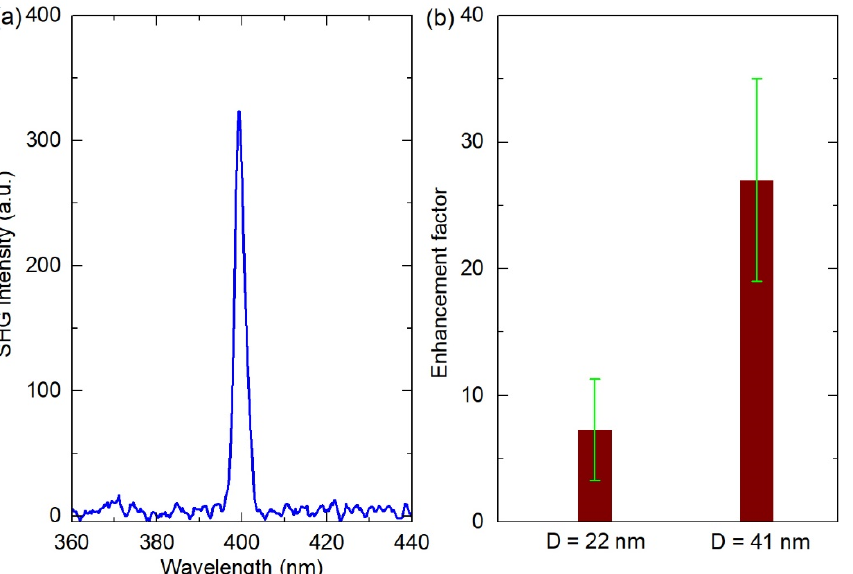
Figure 5. ( a ) Representative SHG spectrum of ZnO nanofilm; ( b ) SHG enhancement factor of ZnO nanofilms on the vertical Au nanorod arrays with the diameters of 22 and 41 nm.